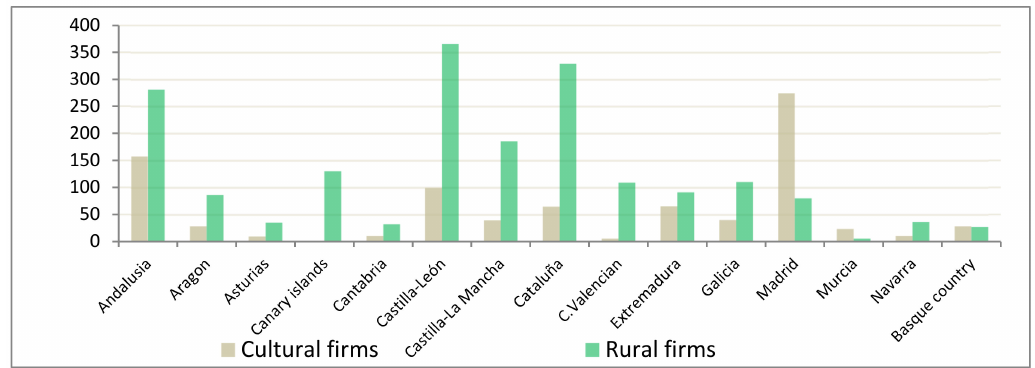
Figure 1. Rural tourism and cultural tourism by Spanish regions (number of firms).